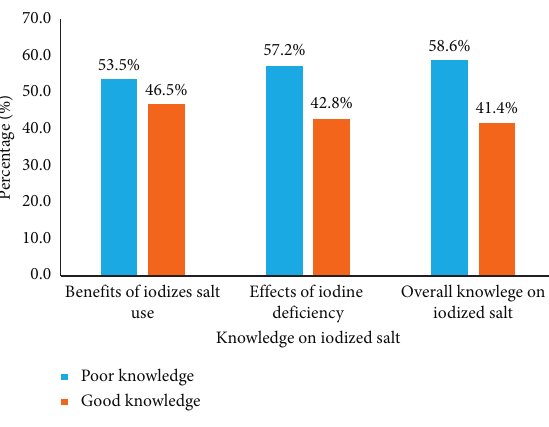
Figure 1: Knowledge on iodized salt.